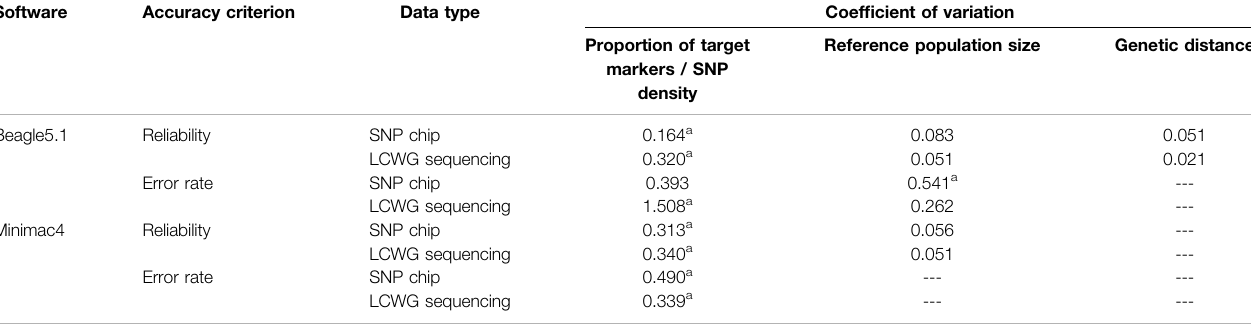
TABLE 8 | Coef fi cient of variation of imputation reliability and imputation error rates.